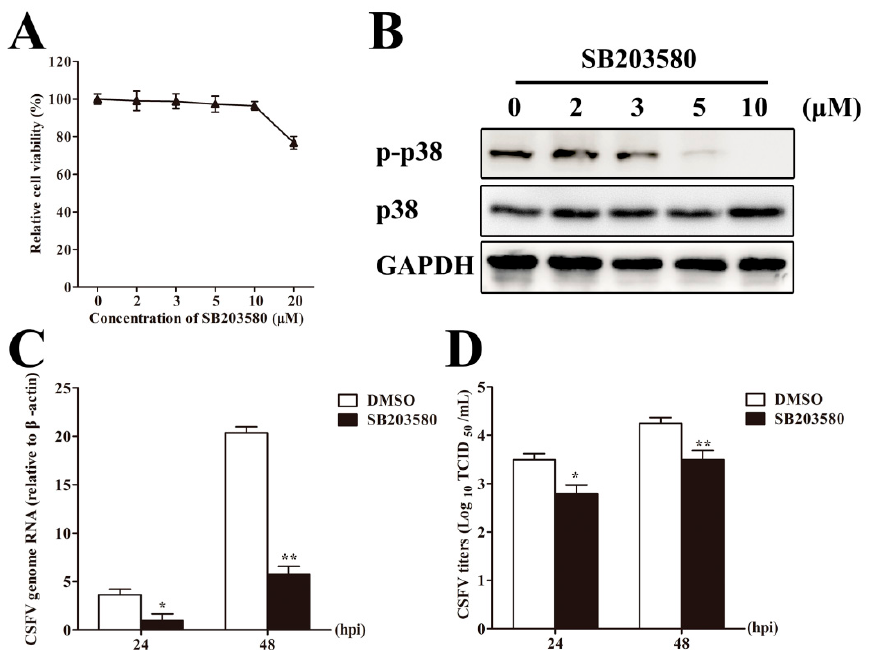
Figure 6. Inhibition of p38 MAPK activation suppresses CSFV replication in PAMs. ( A ) The cell viability in the SB203580 treatment. PAMs were treated with different concentrations of SB203580 for